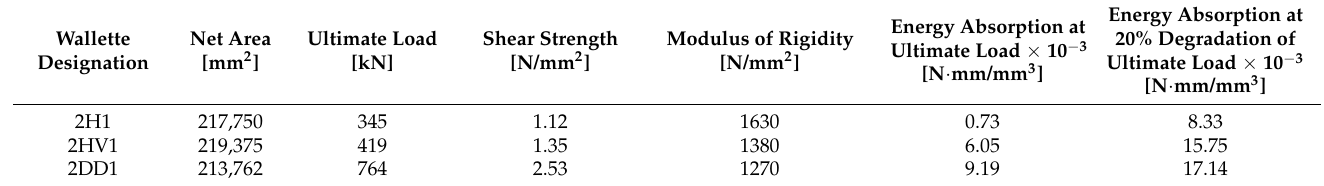
Figure 17. Wallettes reinforced with SB vs. unreinforced ones in terms of ultimate load, shear strength, modulus of rigidity, and absorbed energy at 20% force degradation. ( a ) ultimate load; ( b ) shear strength; ( c ) modulus of rigidity; ( d ) absorbed energy at 20% force degradation. Table 11. Ultimate load, shear strength, modulus of rigidity, and energy absorption of Type 4